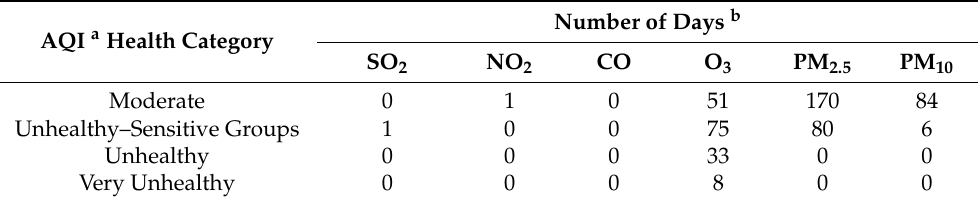
Table 2. Number of days each individual air pollutant was the highest during warm months, Monterrey, Mexico, 2012–2015.